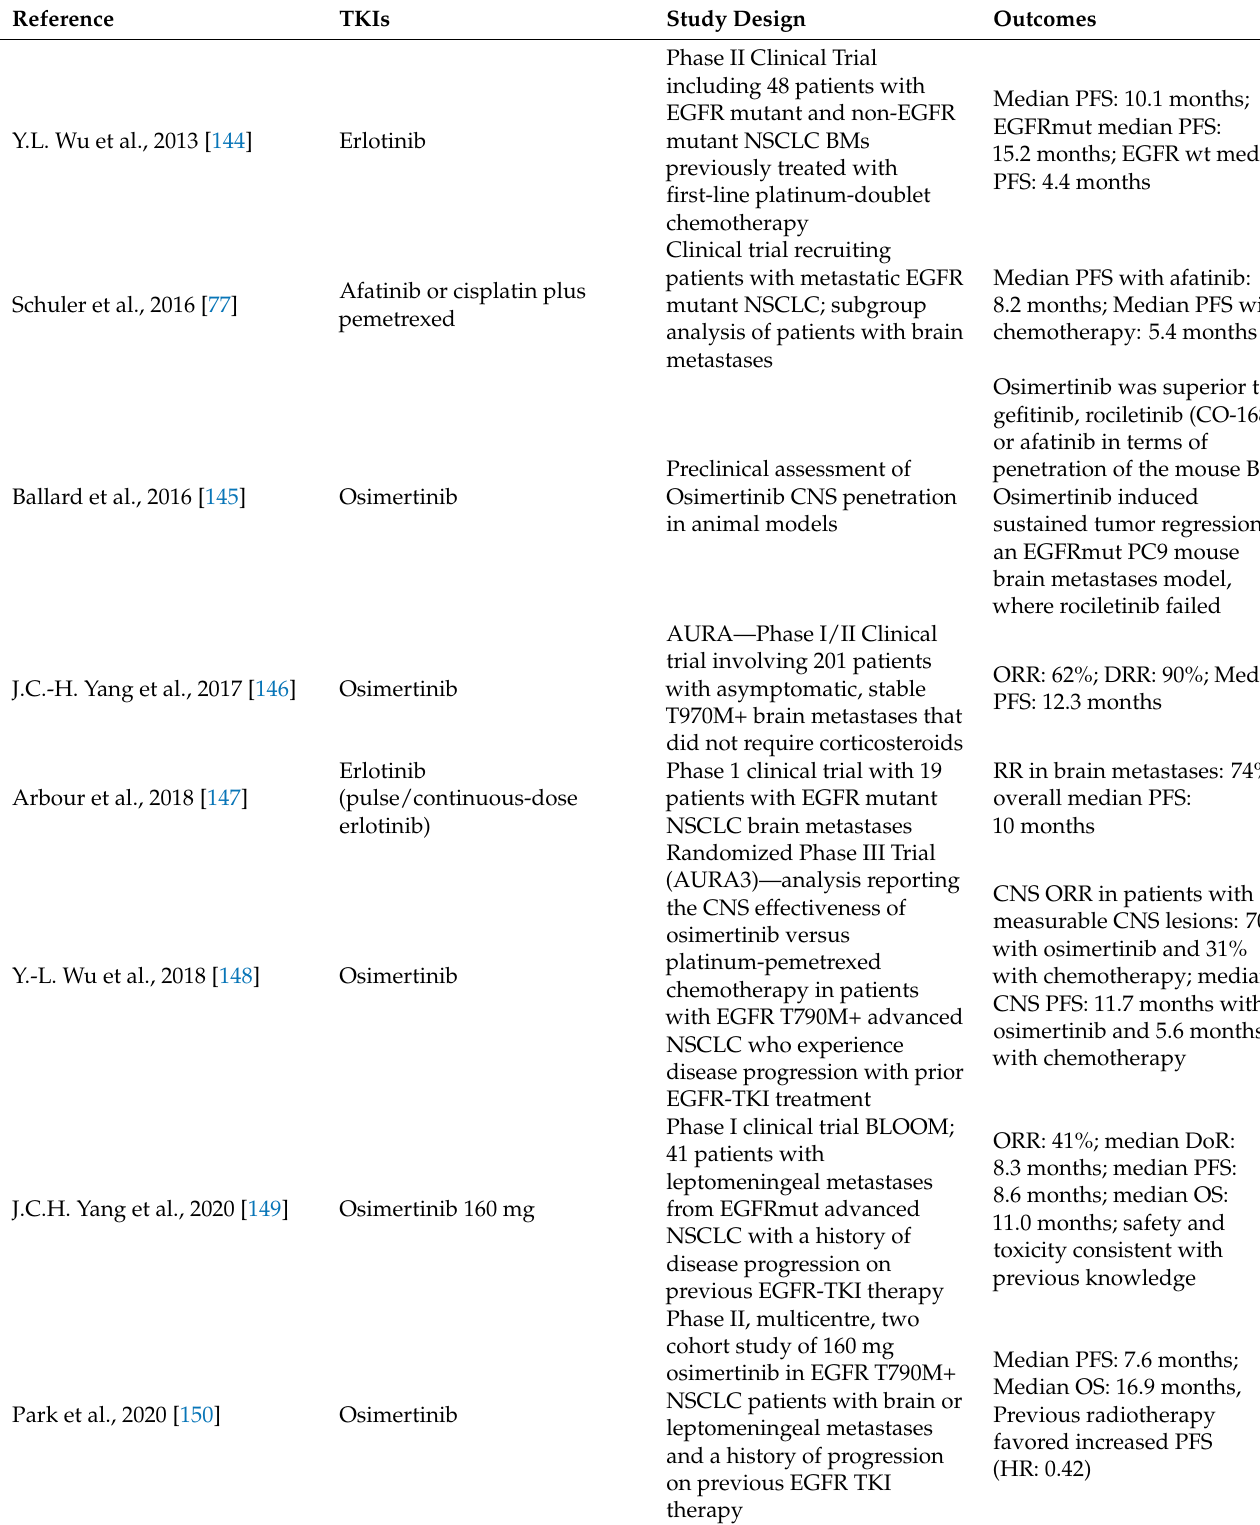
Table 2. Studies evaluating TKIs in EGFR mutant NSCLC brain metastases—EGFR mutant NSCLC (EGFR mut); Progression-Free Survival (PFS); Response rate according to the version 1.1 of the Response Evaluation Criteria in Solid Tumors (RR); Overall control rate (ORR); Disease Control Rate (DRR); Duration of response (DoR); Overall survival (OS); Hazard ratio (HR), Blood–Brain Barrier